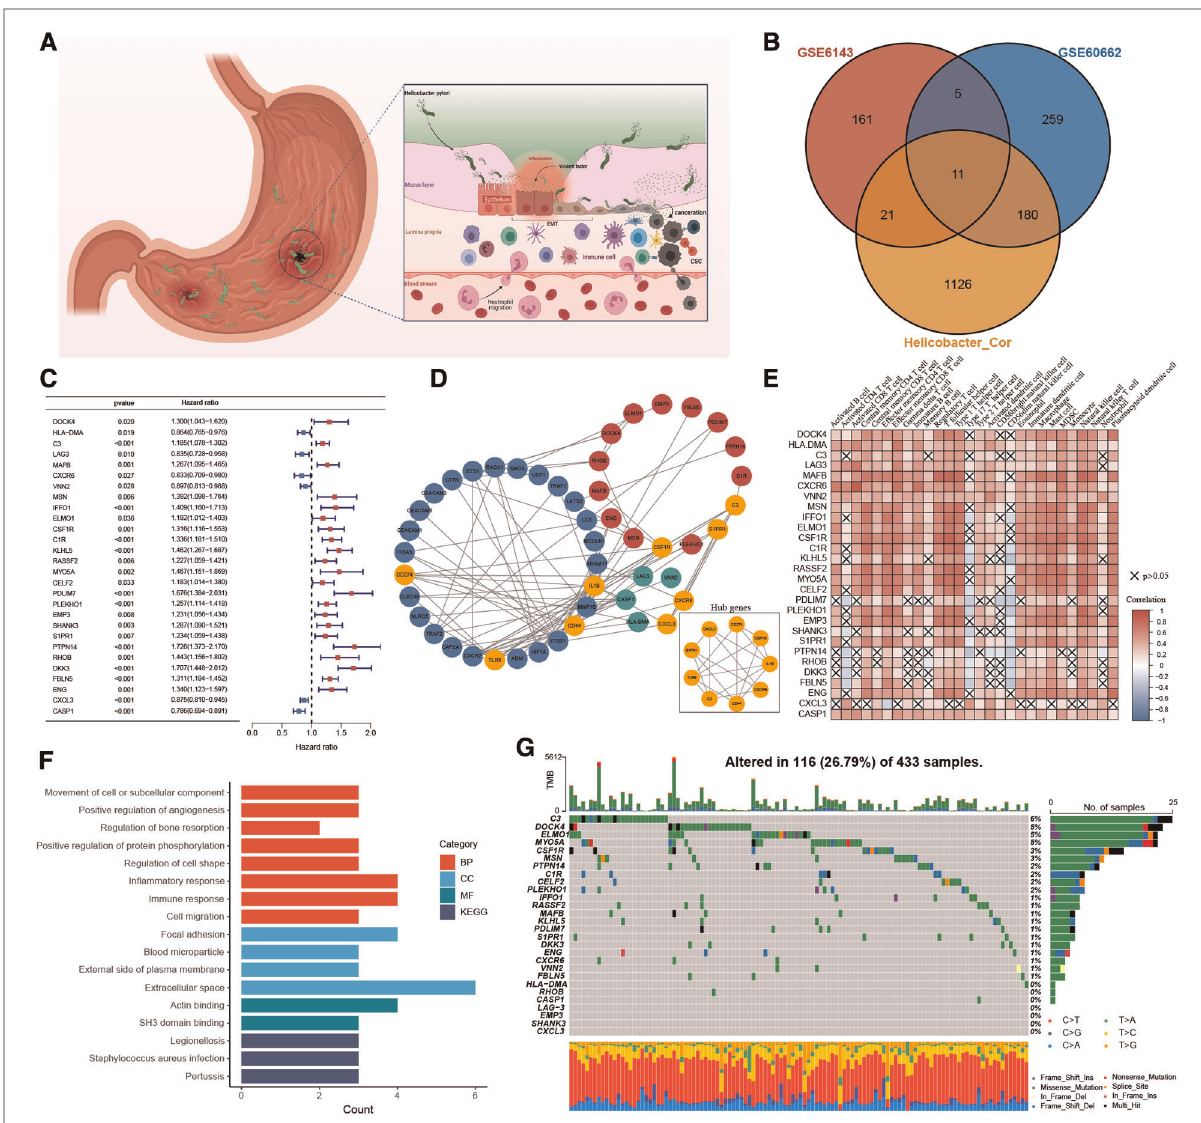
FIGURE 2 The landscape of HP-related prognostic genes in gastric cancer. ( A ) Pathogenesis of Helicobacter pylori. ( B ) Venny diagram displaying the overlap of differential gene expression pro fi les. ( C ) Blue and red represented the hazard ratio by the univariate cox regression model. ( D ) Protein-protein interaction (PPI) network (Blue nodes represent HP-related genes, Green and red are HP-related prognostic genes. Orange represents the hub genes identi fi ed by the mcode method). ( E ) Visualization of the correlation analysis results between HP-related prognostic genes and tumor- in fi ltrating immune cells in the meta-dataset. ( F ) GO and KEGG analysis results of 28 HP-related prognostic genes. ( G ) The mutation information of 28 HP-related prognostic genes was analyzed in the TCGA-STAD